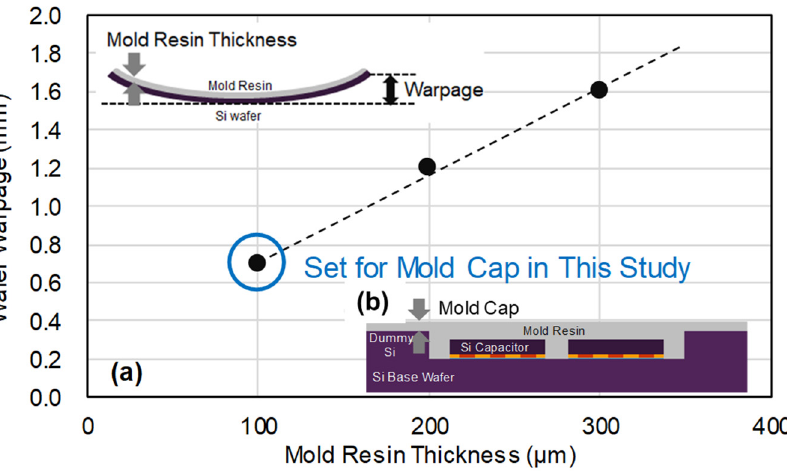
Figure 17. Wafer warpage in resin molding step. ( a ) Wafer warpage as a function of molded resin thickness, and ( b ) cross-sectional image of mold cap in COW process.